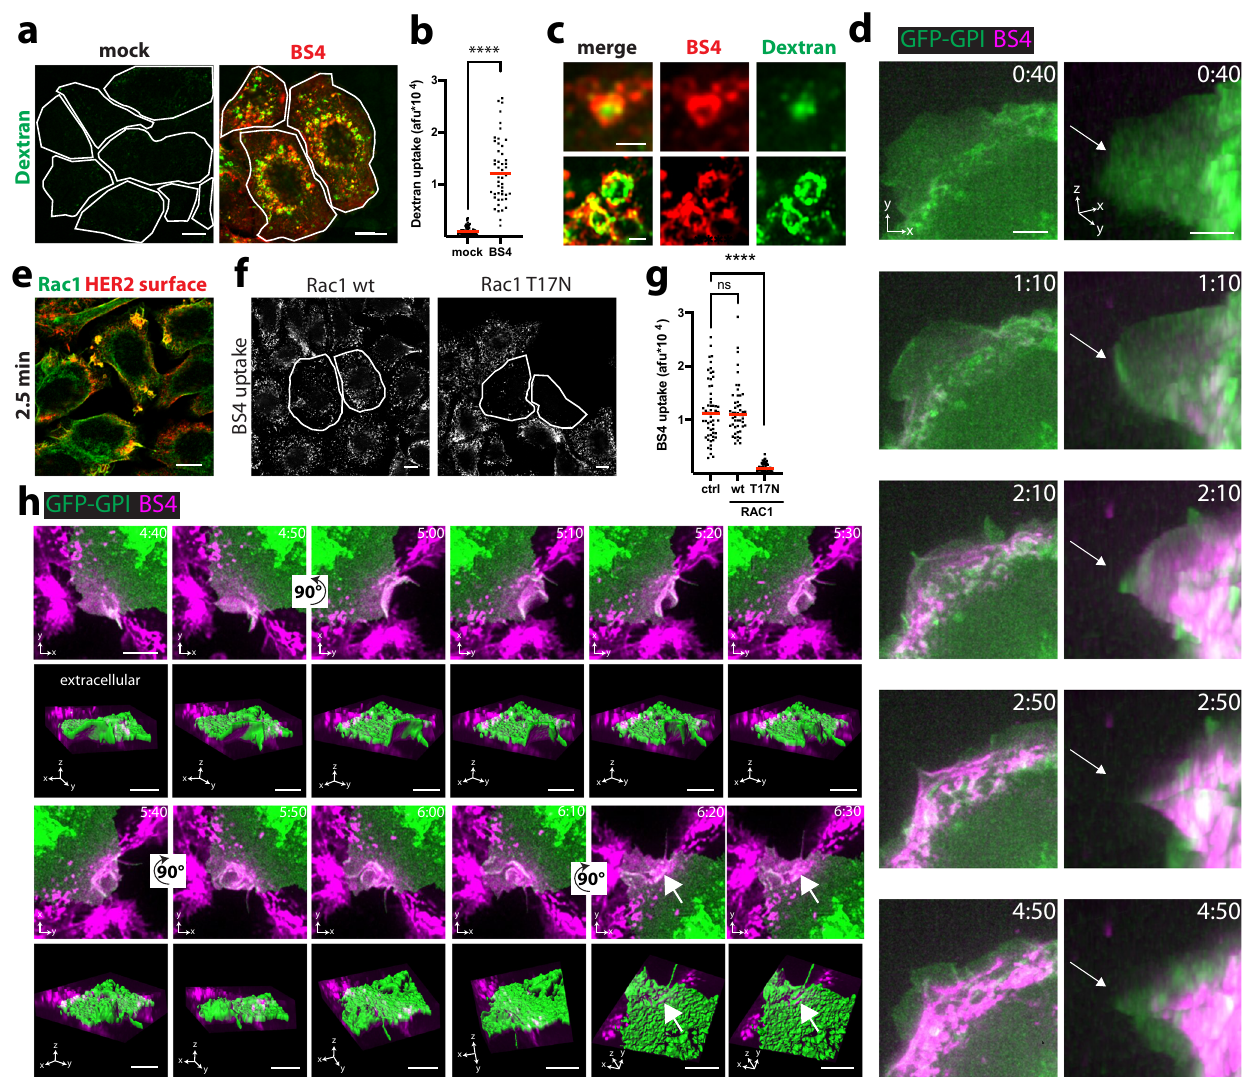
Fig. 2 | Plasma membrane rearrangements during BS4 uptake are Rac1- dependent and morphologically resemble macroendocytosis. a , b BS4 stimulates fl uid-phase uptake. SkBr3 cells were co-incubated with dextran (70kDa)-TMR and BS4-dylight650 for 10min and after fi xation analysed by con- focal microscopy ( a ). The TMR channel is false-colour-coded in green, and indivi- dual cells are outlined. b Quanti fi cation of dextran (70kDa)-TMR endocytosis in absence (mock) and presence of BS4 (dots represent measurements from indivi- dual cells, red lines indicate the median; n ≥ 50 cells from three independent experiments, **** P <0.0001, two-tailed unpaired Student ’ s t test). c BS4-positive endocytic carriers exhibit dextran- fi lled lumina. d Concentration of surface-bound BS4 by inwards moving lamellipodium wave. Cells expressing GPI membrane- bound GFP (green) were imaged immediately after addition of BS4-dylight650 (magenta) (see also Supplementary Movies 3 and 4). 3D views ( x , y , z dimensions) are shown on the right. The arrows indicate the position of the plasma membrane edge at the 40s timepoint. e Rac1 re-localises to BS4-induced HER2 cell-surface aggregates. SkBr3 cells were incubated with BS4 for 2.5min, fi xed, stained for surface HER2 (red) and endogenous RAC (green) and analysed by confocal